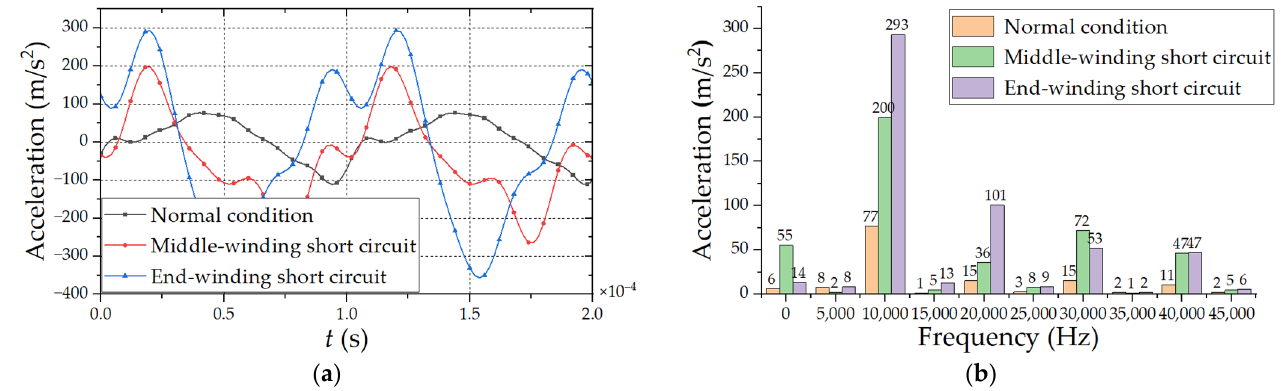
Figure 11. Comparison of vibration acceleration under different continuous winding fault positions ( a ) Time domain waveform diagram. ( b ) Harmonic response analysis.